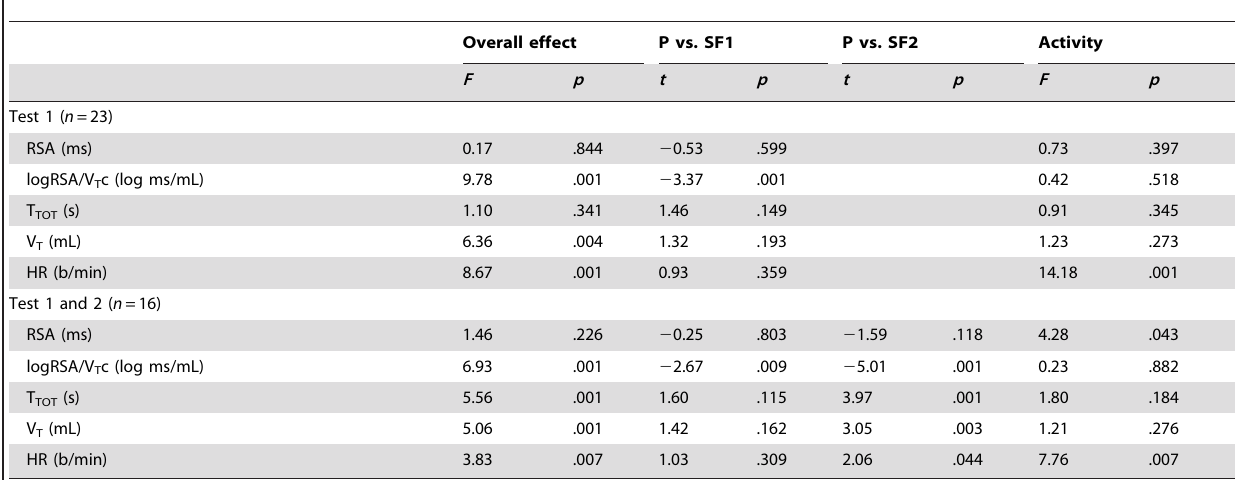
Table 6. RSA, respiration, and heart rate across Still-Face Test episodes controlled for physical activity: Linear mixed model overall F tests ( df =2 or 4, 50.0 to 67.7), time-varying covariate activity effect F -tests ( df =1, 25.7 to 77.8) and t -tests ( df =52.4 to 77.7) testing changes from Play to Still-Face episode 1 and